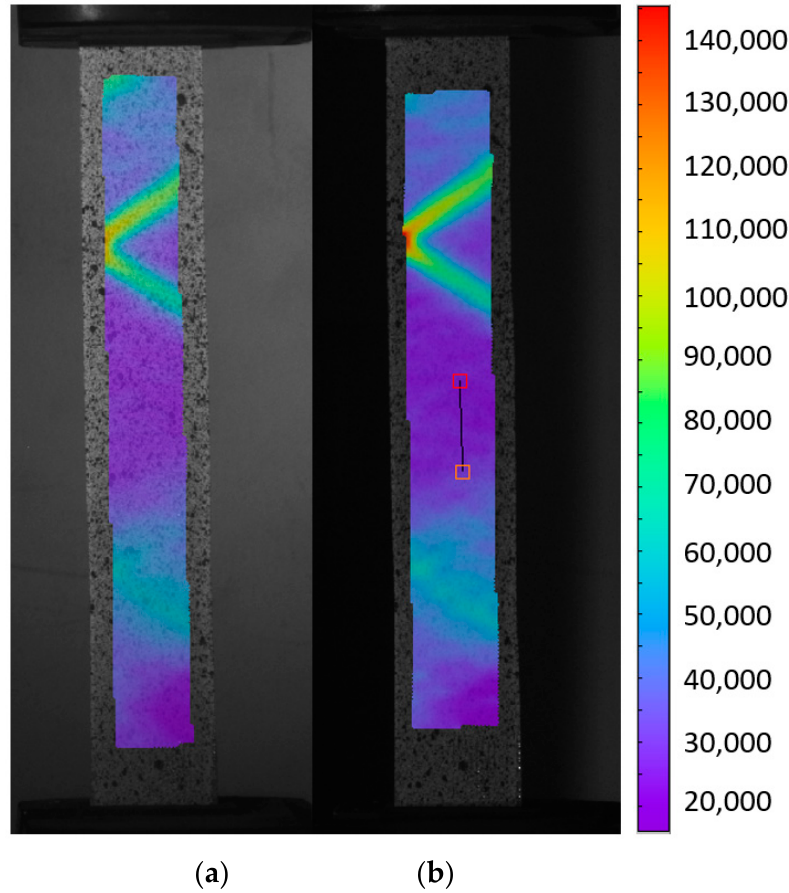
Appl. Sci. 2019 , 9 , x FOR PEER REVIEW Figure 12. Cloud map of strain before fracture/strain. ( a ) proposed system; ( b ) Q-400 DIC system.